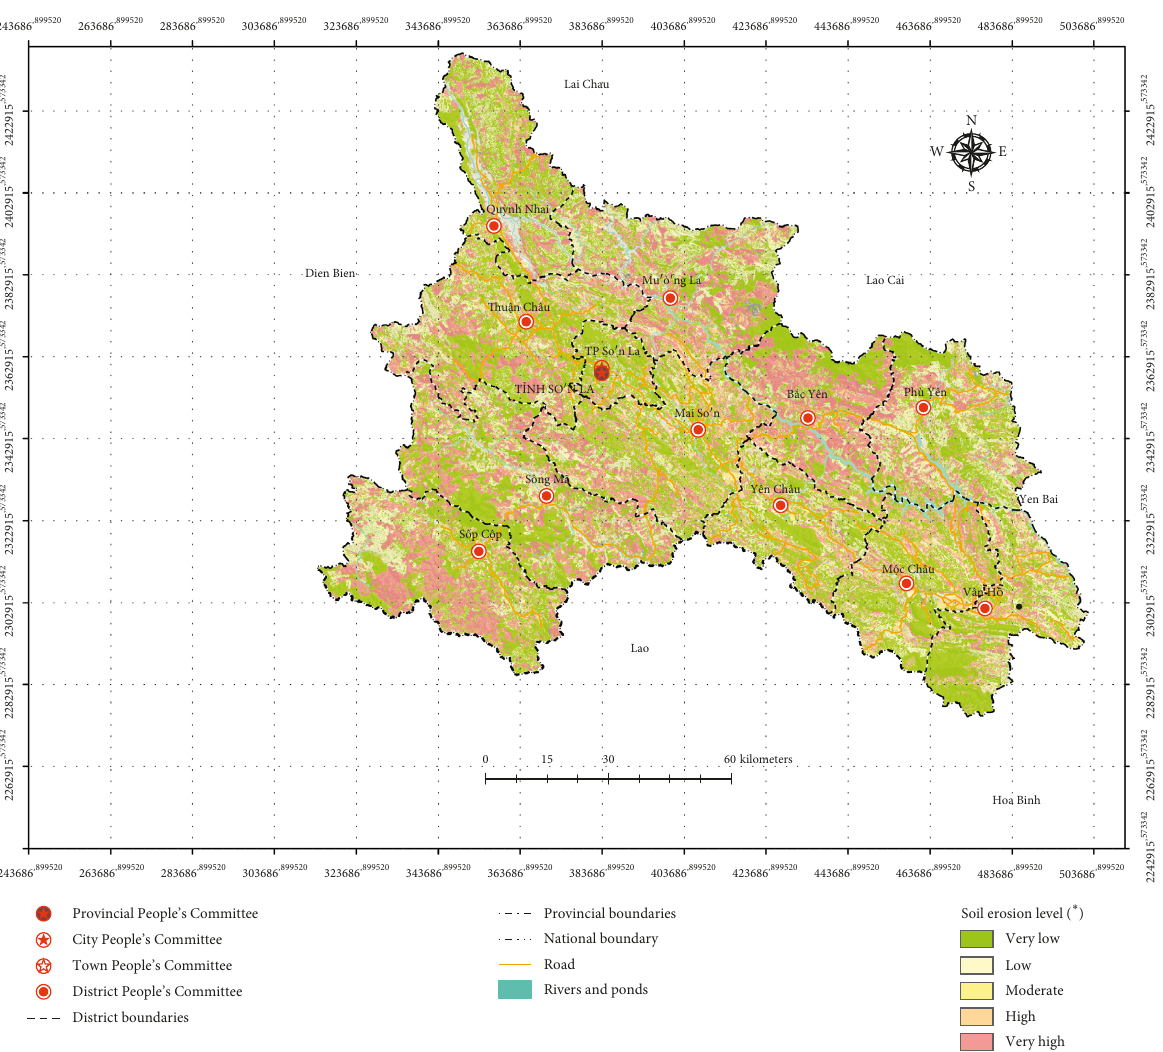
Figure 3: Soil erosion map in Son La. Table 4: Soil loss levels and areas in the Son La province. Soil erosion levels Soil loss (ton ·